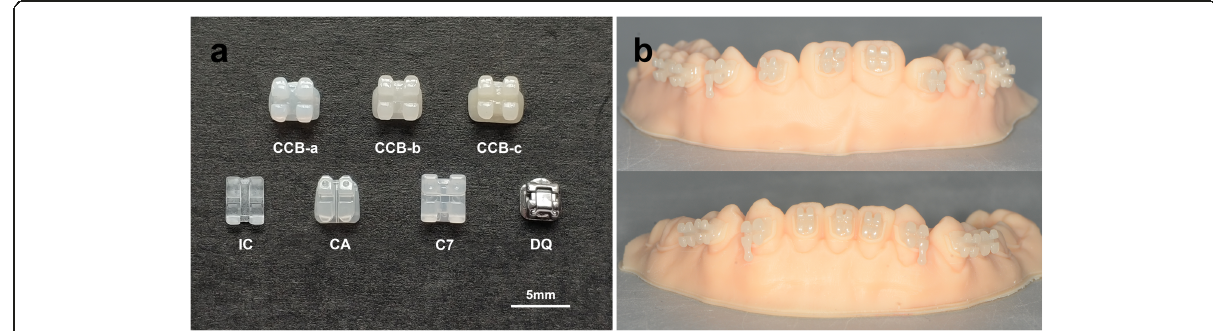
Fig. 3 Images of brackets: a the different opacity CCB (CCB-a, CCB-b, CCB-c) and commercial brackets (IC, CA, C7 and DQ); b customized ceramic brackets bonded on teeth model for fabricating indirect transfer jigs